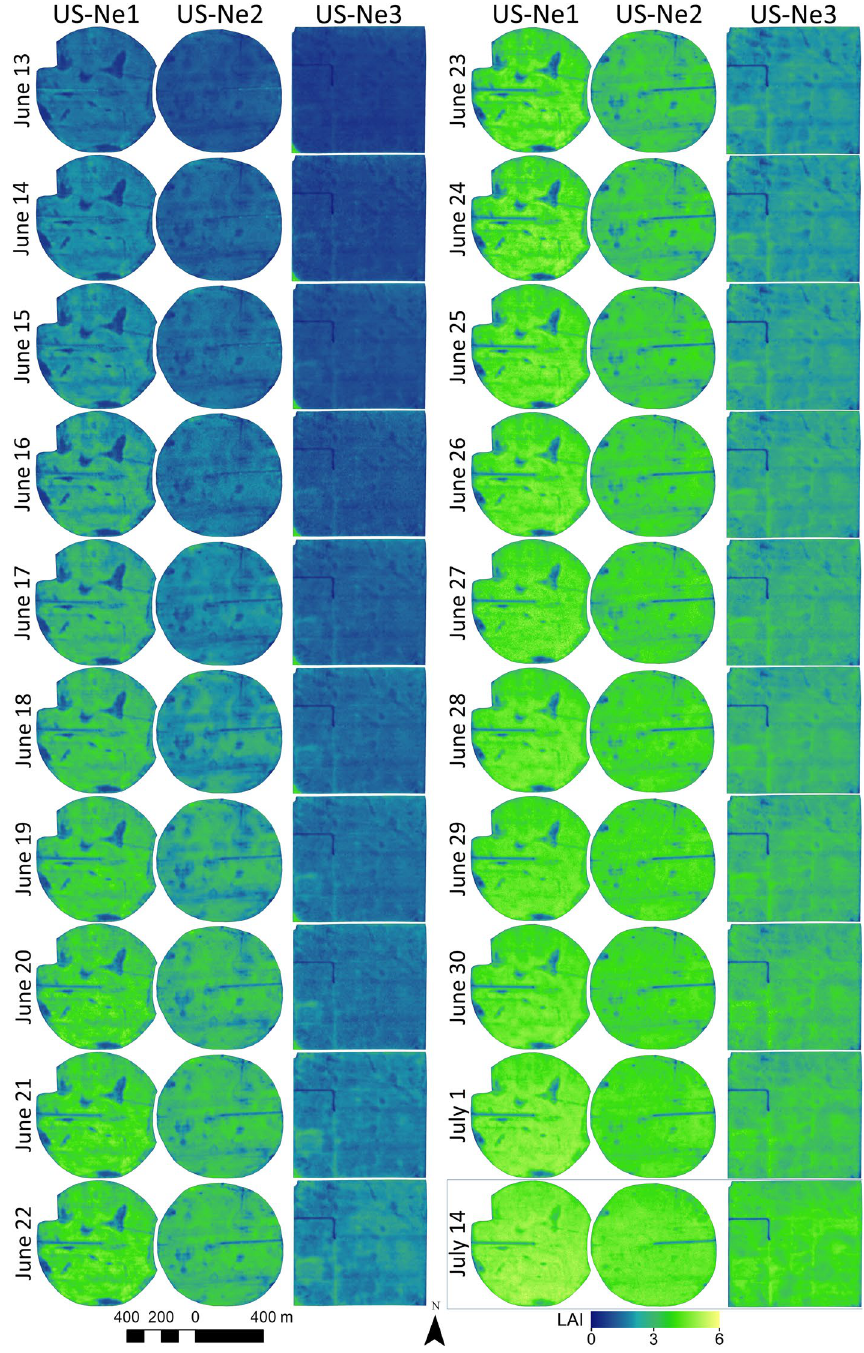
Figure 4. Daily sequence of leaf area index (LAI) maps, covering 19 days (June 13–July 1, 2019) during part of the vegetative stage and one selected day (14 July) with peak LAI values of the two irrigated US-Ne1 and Ne2 fields and the non-irrigated US-Ne3 field. Software used to produce the maps: ArcGIS version 10.8.1 (www. esri. com/ en- us/